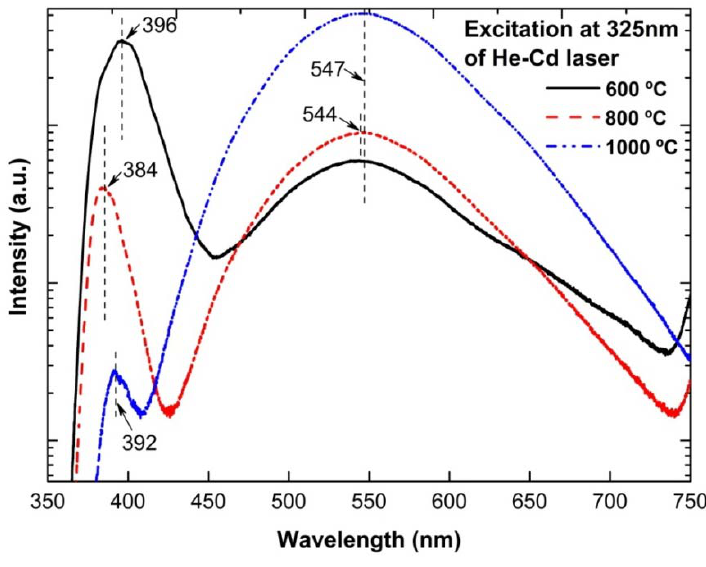
Figure 7. Room temperature photoluminescence (PL) spectra of ZnO nanorods grown on PS substrates at different growth